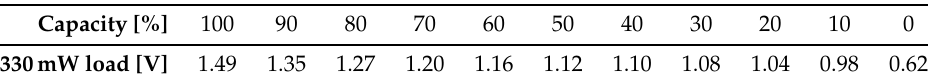
Table 2. Cell voltage for a 330mW load in terms of remaining capacity of an AA Alkaline battery (10800J) [25].